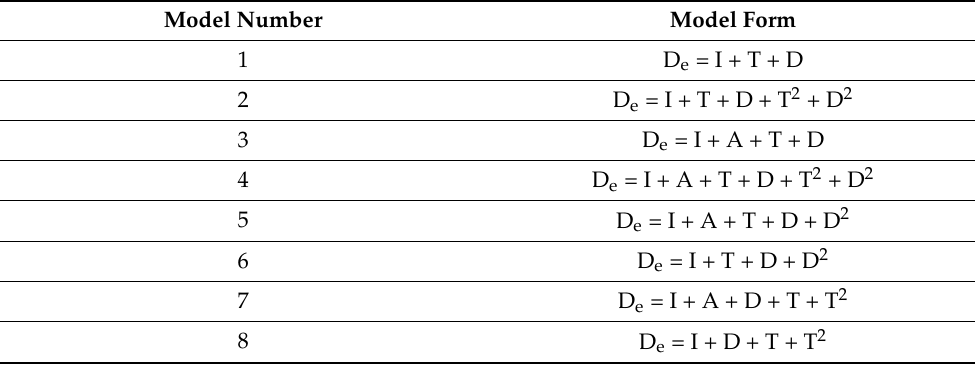
Table 1. Forms of original models used to account for the influence of independent variables and environmental covariates of air temperature and discharge on GW, LW, and BW of white sucker; De = Dependent; I = Independent; T = Temperature; D = Discharge; A = Age. Model Number Model Form